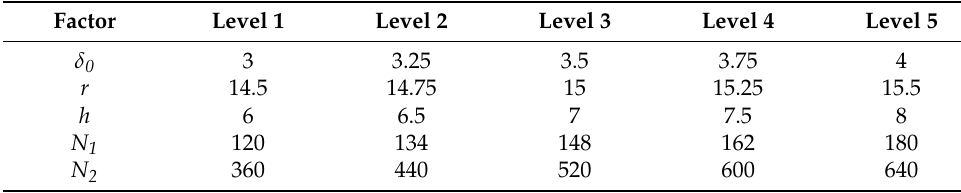
Table 3. Factor level